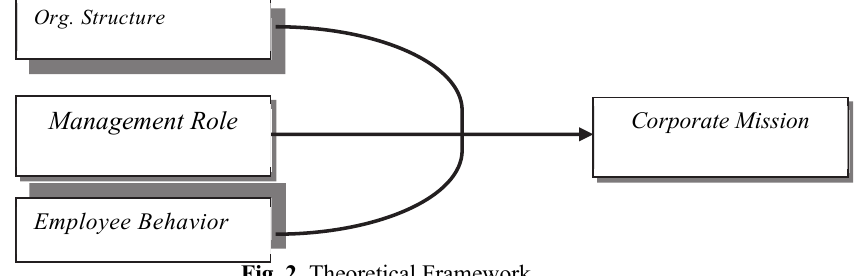
Fig. 2. Theoretical Framework